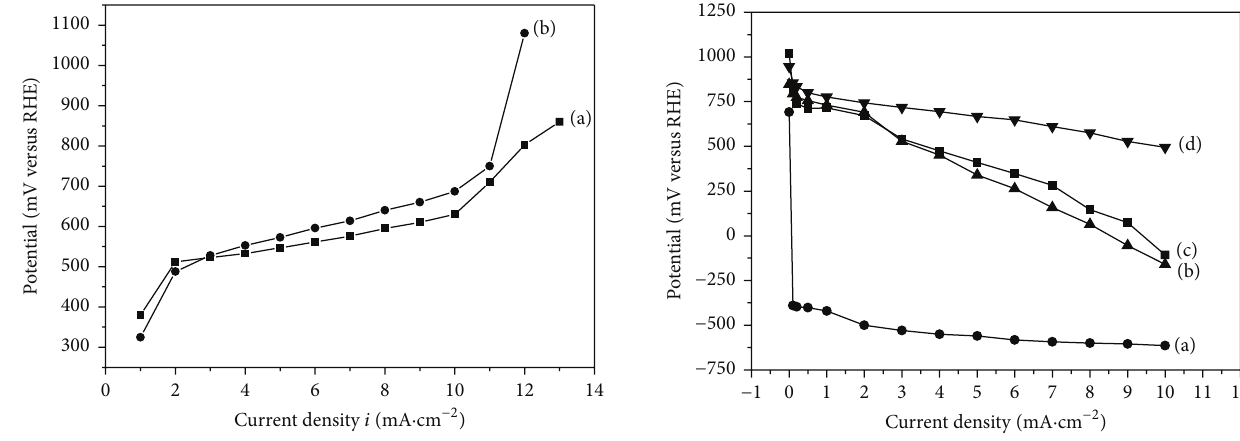
Gmbh”, Germany, is applied. The counter electrode is Pt- foil. A minimum of four measurements were made for each result to achieve better reproducibility. Arithmetic averages